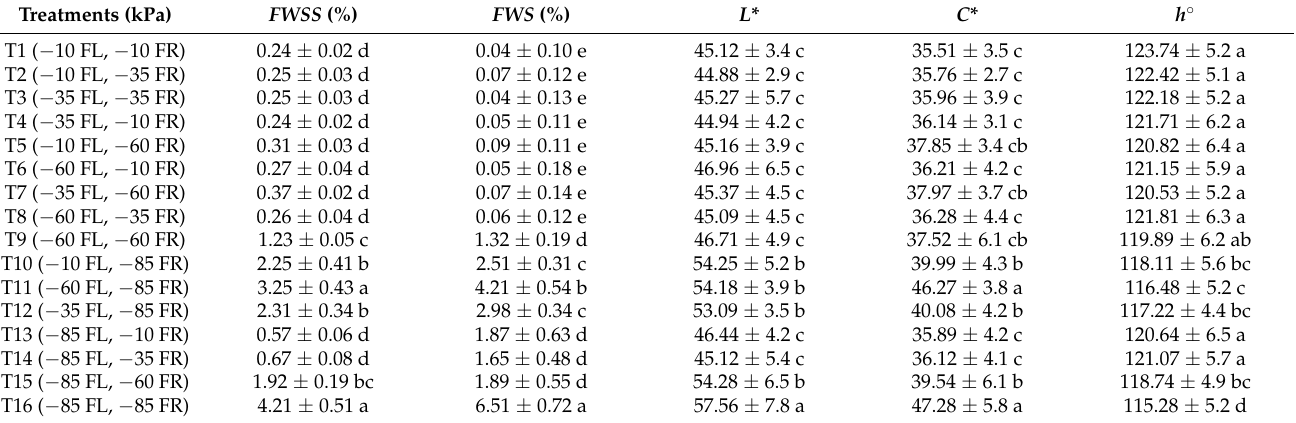
Table 5. Percentage of fruits with sun spots ( FWSS ), percentage of fruits with scarring ( FWS ), fruits luminance ( L *), fruits chroma or color saturation ( C *), and fruits hue or color angle ( h ◦ ) in the treatments